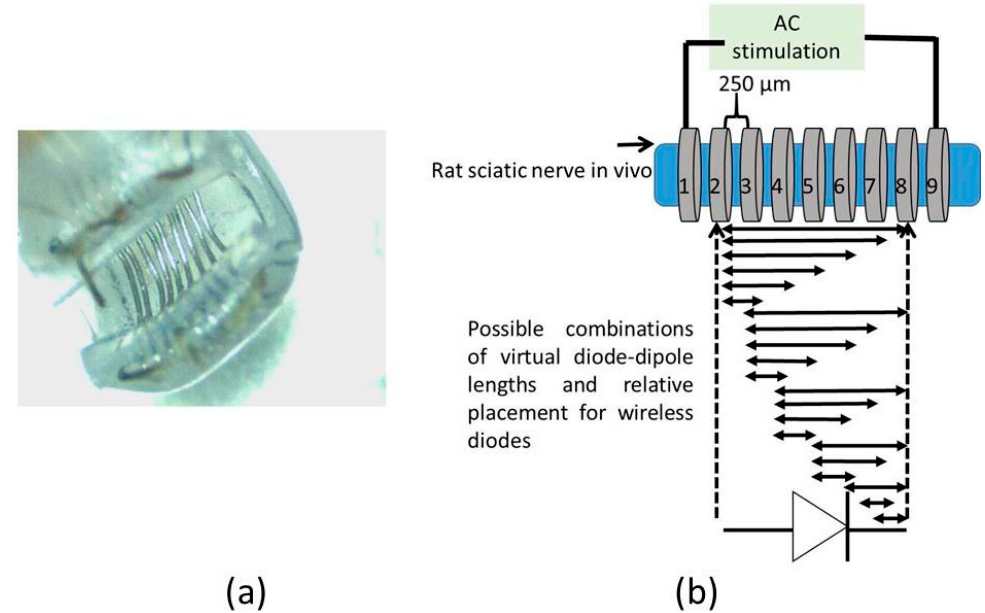
Figure 3. Nerve cuff-based platform was used to test currents through a diode placed superficially on a nerve for different diode–dipole lengths and placement of diodes relative to the external alternating current (AC) excitation voltages. ( a ) Image of a 9-ring nerve cuff with 100 µm diameter platinum leads spaced 250 µm apart. ( b ) Rings ‘1’ and ‘9’ were used to supply AC stimulus drive voltage (10 kHz–1 MHz) on the nerve. Rings ‘2’ through ‘8’ were used to test different combinations of diode–dipole lengths and the position relative to the AC drive voltages.